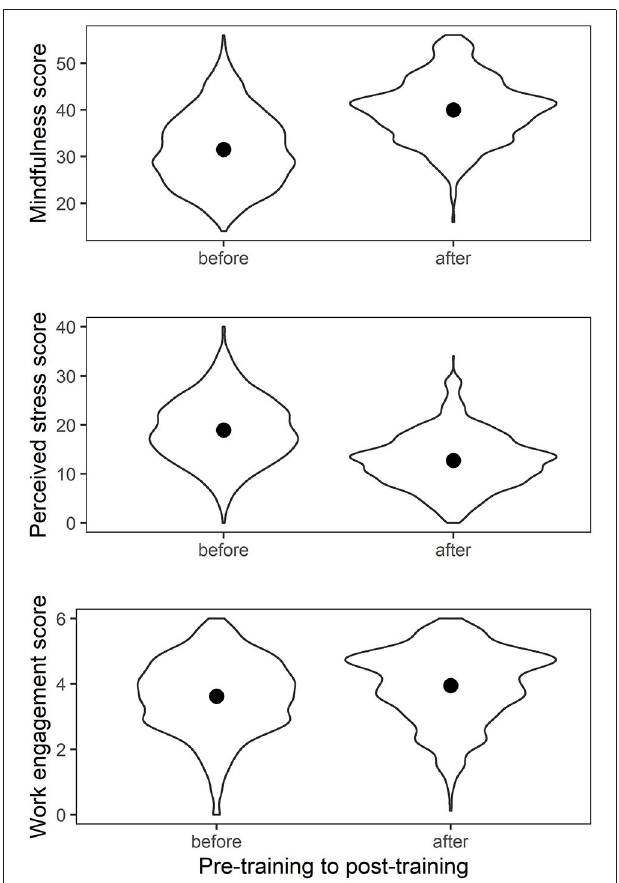
FIGURE 2 | Difference in means from pre- to post-training for mindfulness, perceived stress, and work engagement. Violin plots show the kernel density of observations at each score on the Y axis reflected along the midline, to illustrate the distribution of scores by timepoint. Error bars are 95% confidence intervals, but because the sample is so large they appear to be super-imposed.